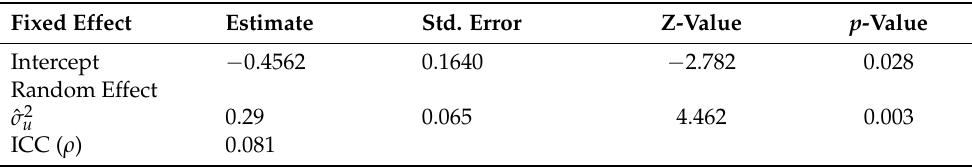
Table 2. Result of the variance component